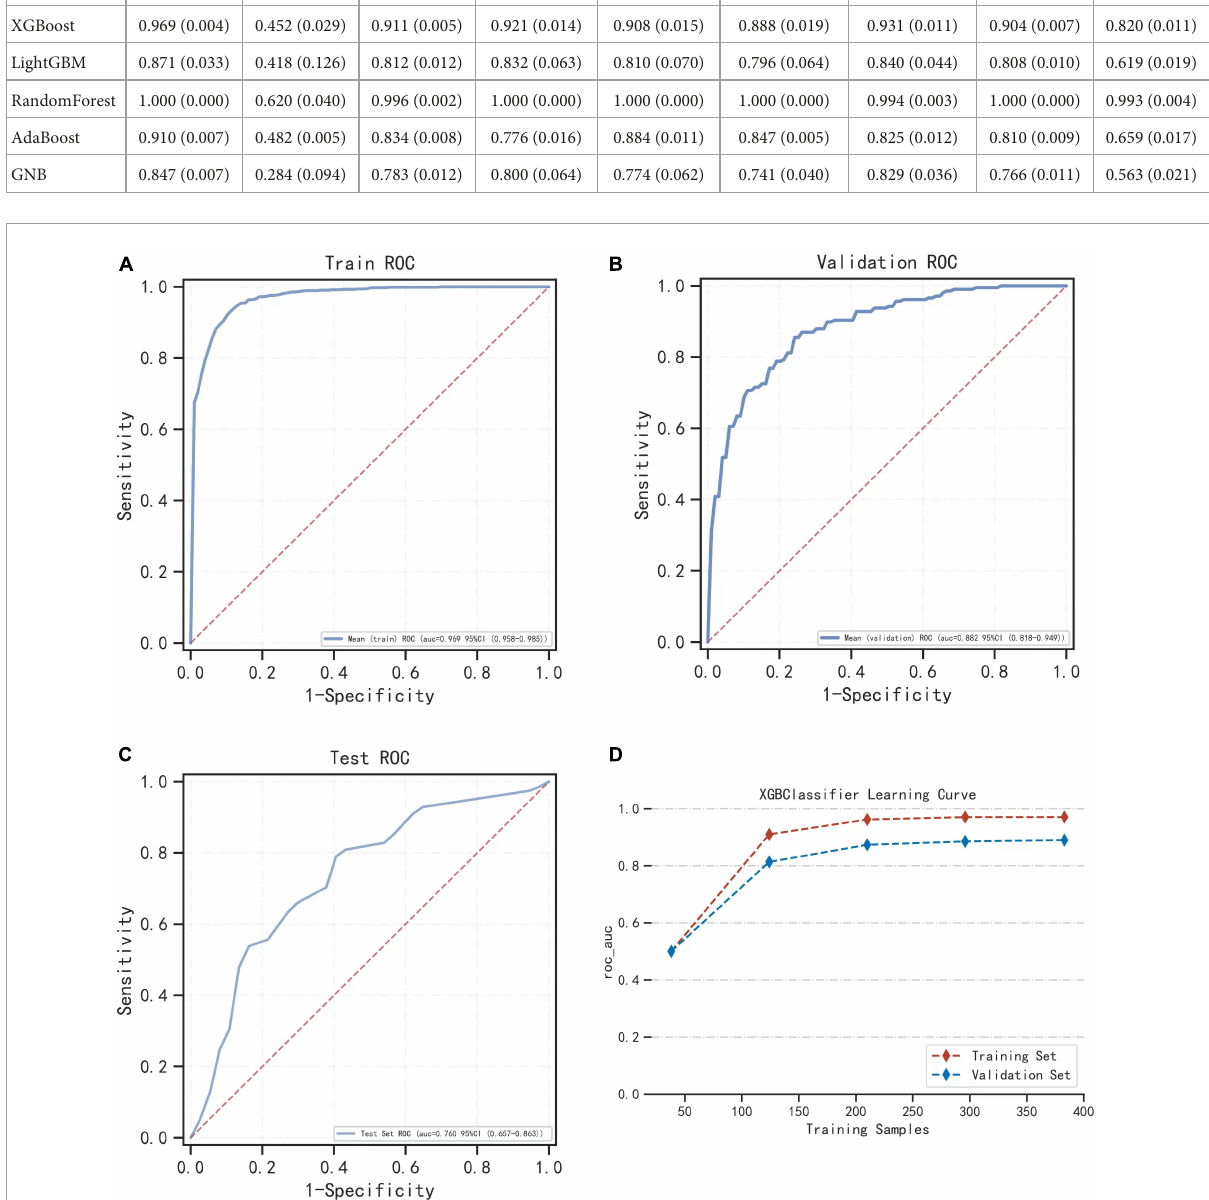
FIGURE3 The performance of the model built by the XGBoost algorithm. (A) The ROC result of the model established by the XGBoost algorithm in the training set. (B) The ROC result of the model established by the XGBoost algorithm in the validation set. (C) Shows the results of the ROC of the model established by the XGBoost algorithm in the training set and the verification set according to the change of the sample size. (D) During cross-validation, the ROC of the training set and the validation set varies with the sample size of the training